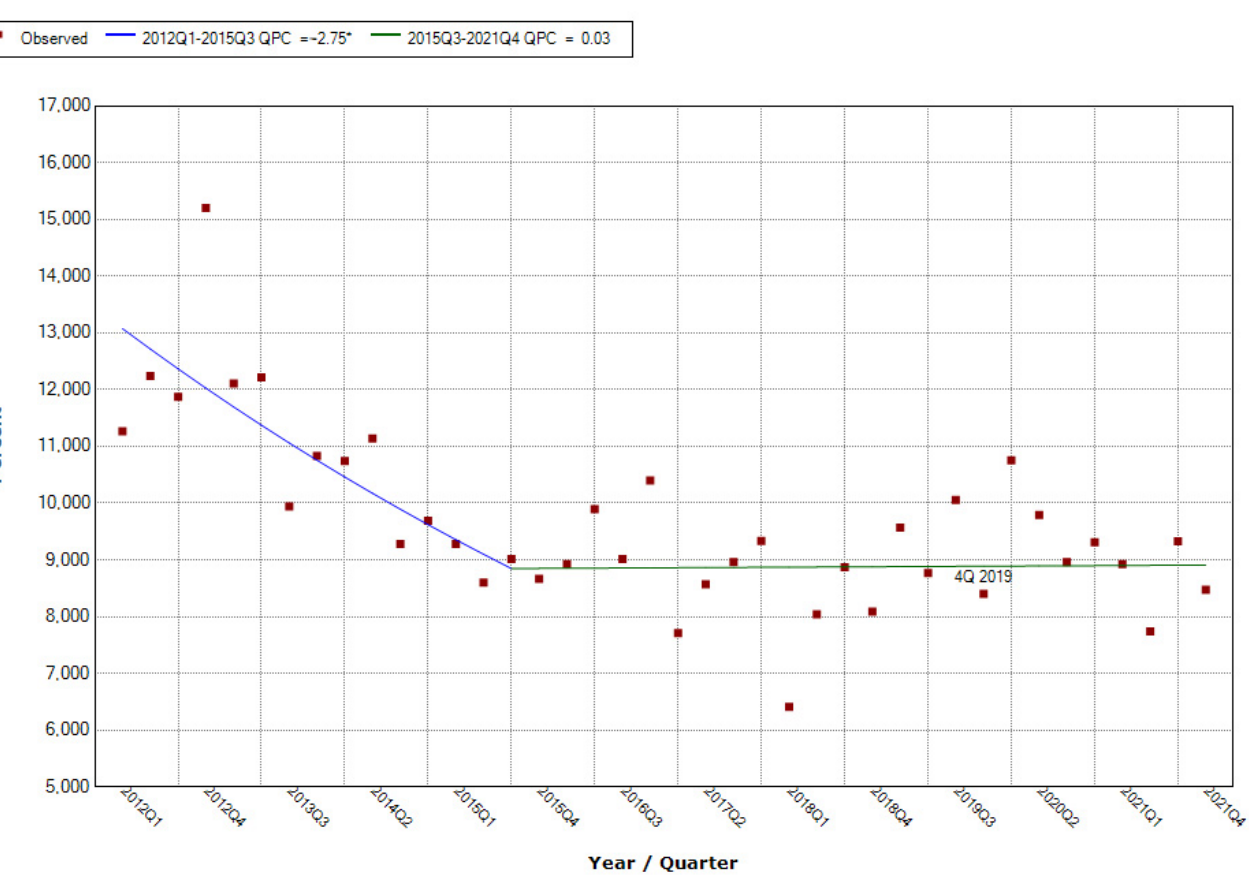
Figure A25. Percentage of products containing vitamin B2 in individual quarters in the period from 2012 to 28 November 2021. Joinpoints mark trend turning points. The date above the observation indicates the moment of publication of the scientific opinion/resolution.